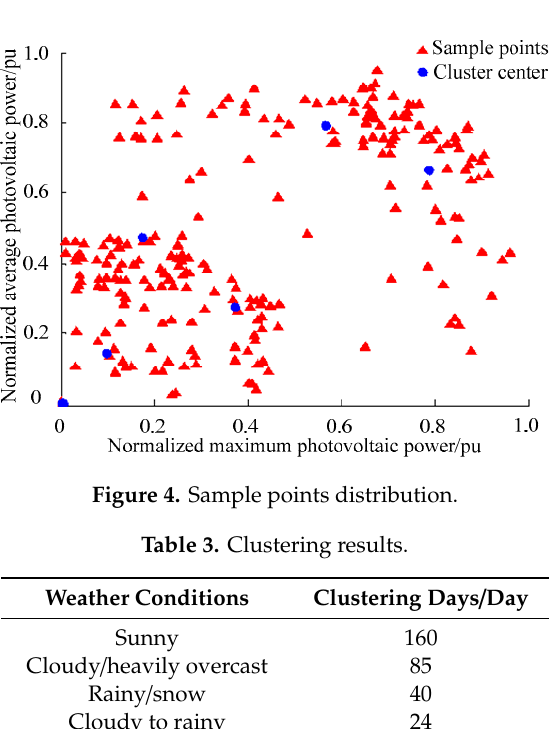
Figure 3. The original PV power series in April 2015.